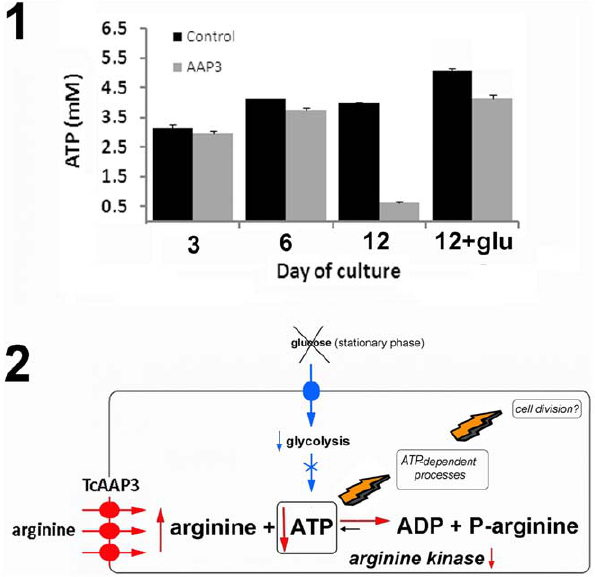
Figure 3. Regulation of arginine metabolism and ATP levels by TcAAP3. 1) Intracellular ATP concentrations were measured using